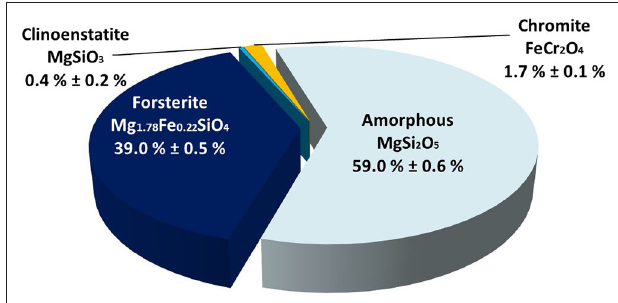
FIGURE 6 | Mineral composition (wt%) of the ferronickel slag